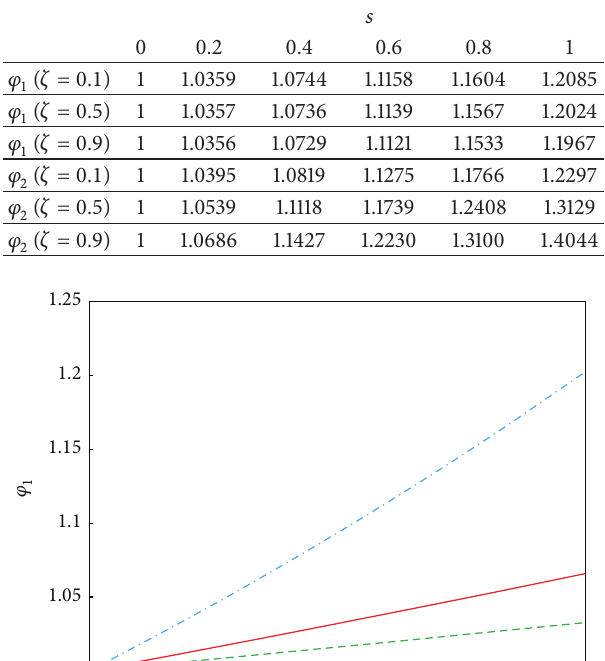
Table 2: Steady-state vibration amplitudes ratios 𝜑 1 and 𝜑 2 of SWCNT for different compressive axial ratio 𝜁 .